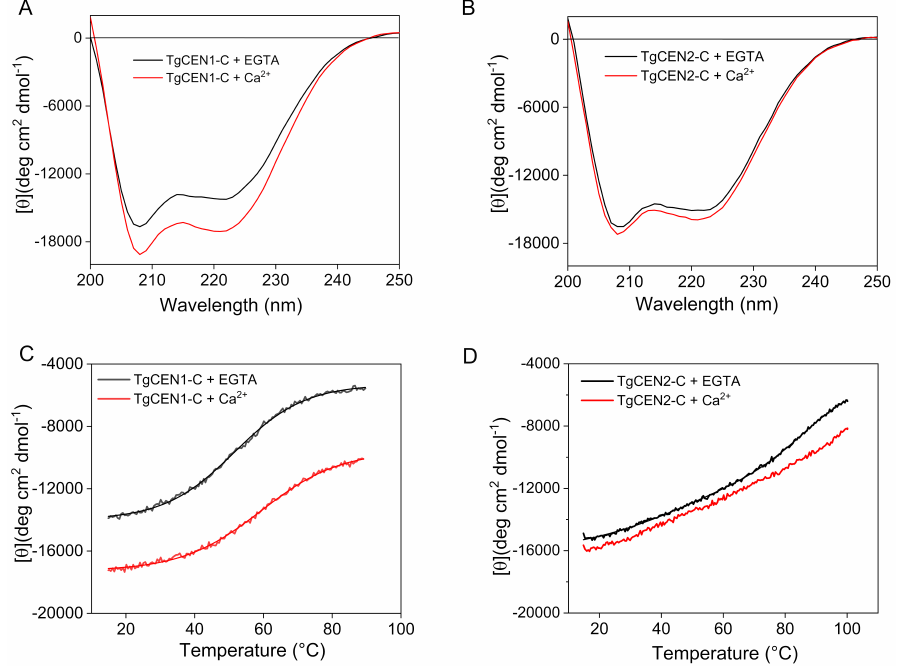
Figure 3. Far-UV CD spectra and thermal stability. ( A , B ) Far-UV CD spectra of 0.2 mg / mL TgCEN1-C ( A )andTgCEN2-C( B )inthepresenceof2mMEGTA(black)and2mMCaCl 2 (red). ( C , D )Representative thermal denaturation profiles of TgCEN1-C ( C ) and TgCEN2-C ( D ) in the presence of 2 mM EGTA (black) and 2 mM CaCl 2